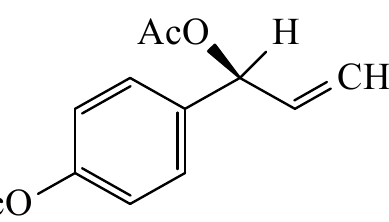
Figure 1. The chemical structure of 1 ′ - S -acetoxychavicol acetate ( S -ACA) from A. galanga.